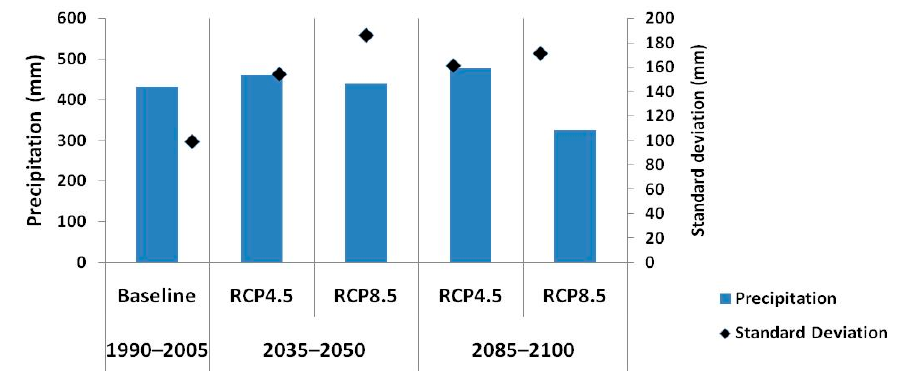
Figure 6. Annual rainfall averages under baseline and both Representative Concentration Pathways (RCPs), as well as standard deviation values.